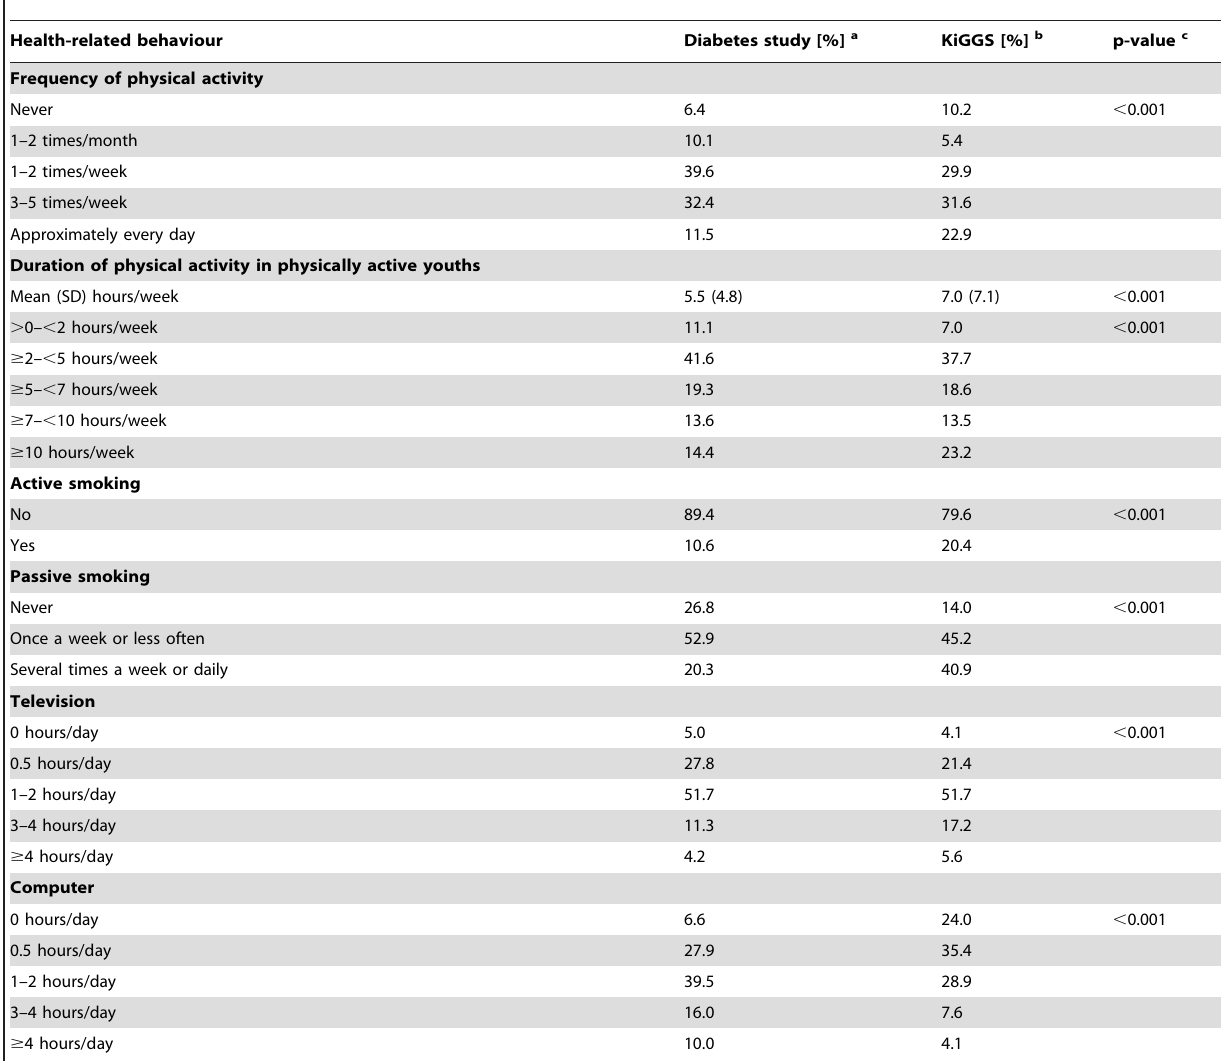
Table 2. Prevalence of health-related behaviours in children and adolescents with type 1 diabetes and KiGGS participants.